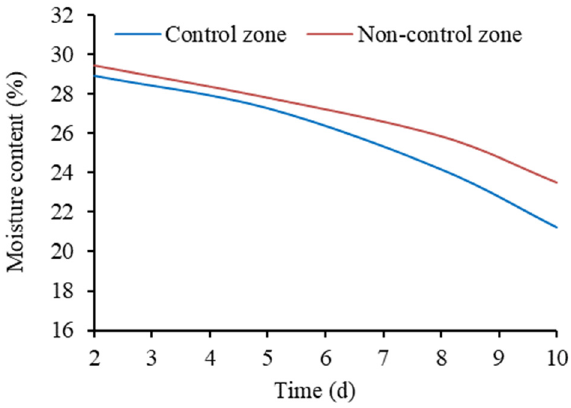
Figure 14. Changes in the topsoil ECe changing rates in control and non-control zones.